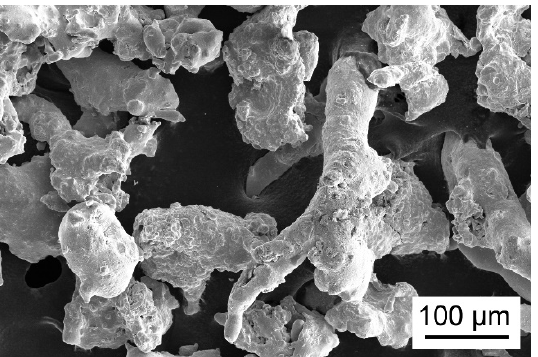
Figure 1. ETD (secondary electrons) SEM images of the starting particles of 17-4PH.